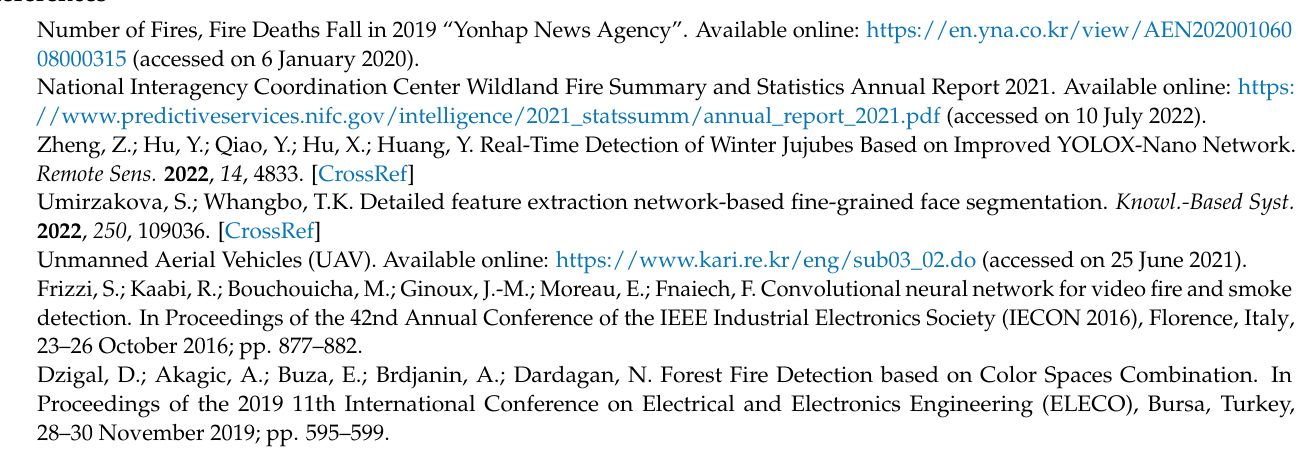
Figure A2. Our additional results.